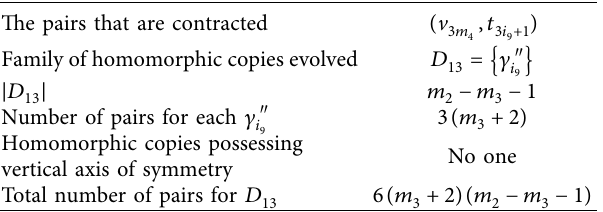
Table 13: Necessary information regarding homomorphic copies 􏽮 􏽯 . δ ( i 10 ,i 11 ) The pairs that are contracted ( s Family of homomorphic copies evolved Number of pairs for each δ ( i